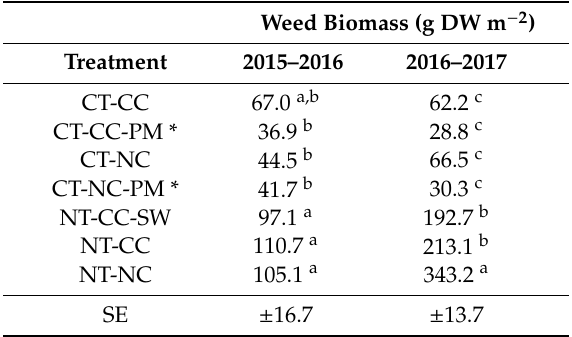
Table 7. Weed biomass measured in each system at